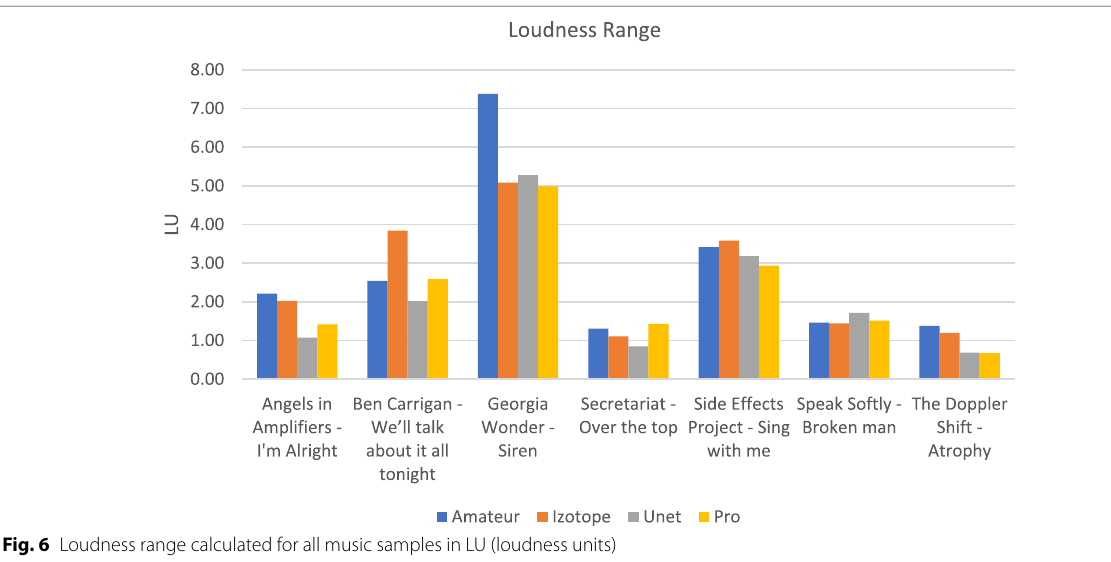
Fig. 6 Loudness range calculated for all music samples in LU (loudness units)